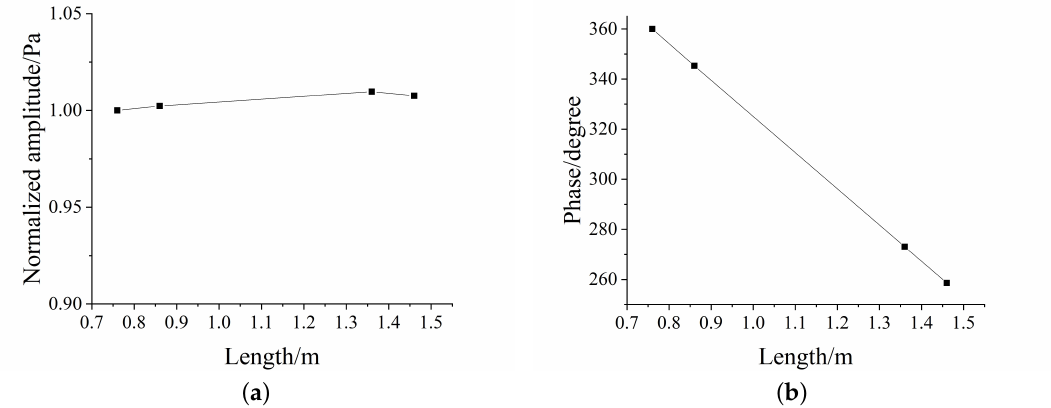
Figure 15. ( a ) The relationship between acoustic pressure amplitude and impedance tube length without sample at 600 Hz. ( b ) The relationship between acoustic phase and impedance tube length without sample at 600 Hz.